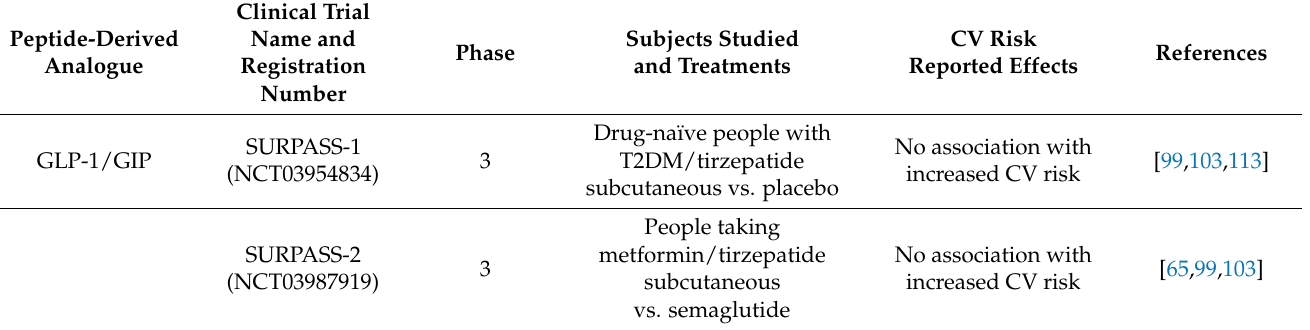
Table 1. Clinical trials of GPCR dual and